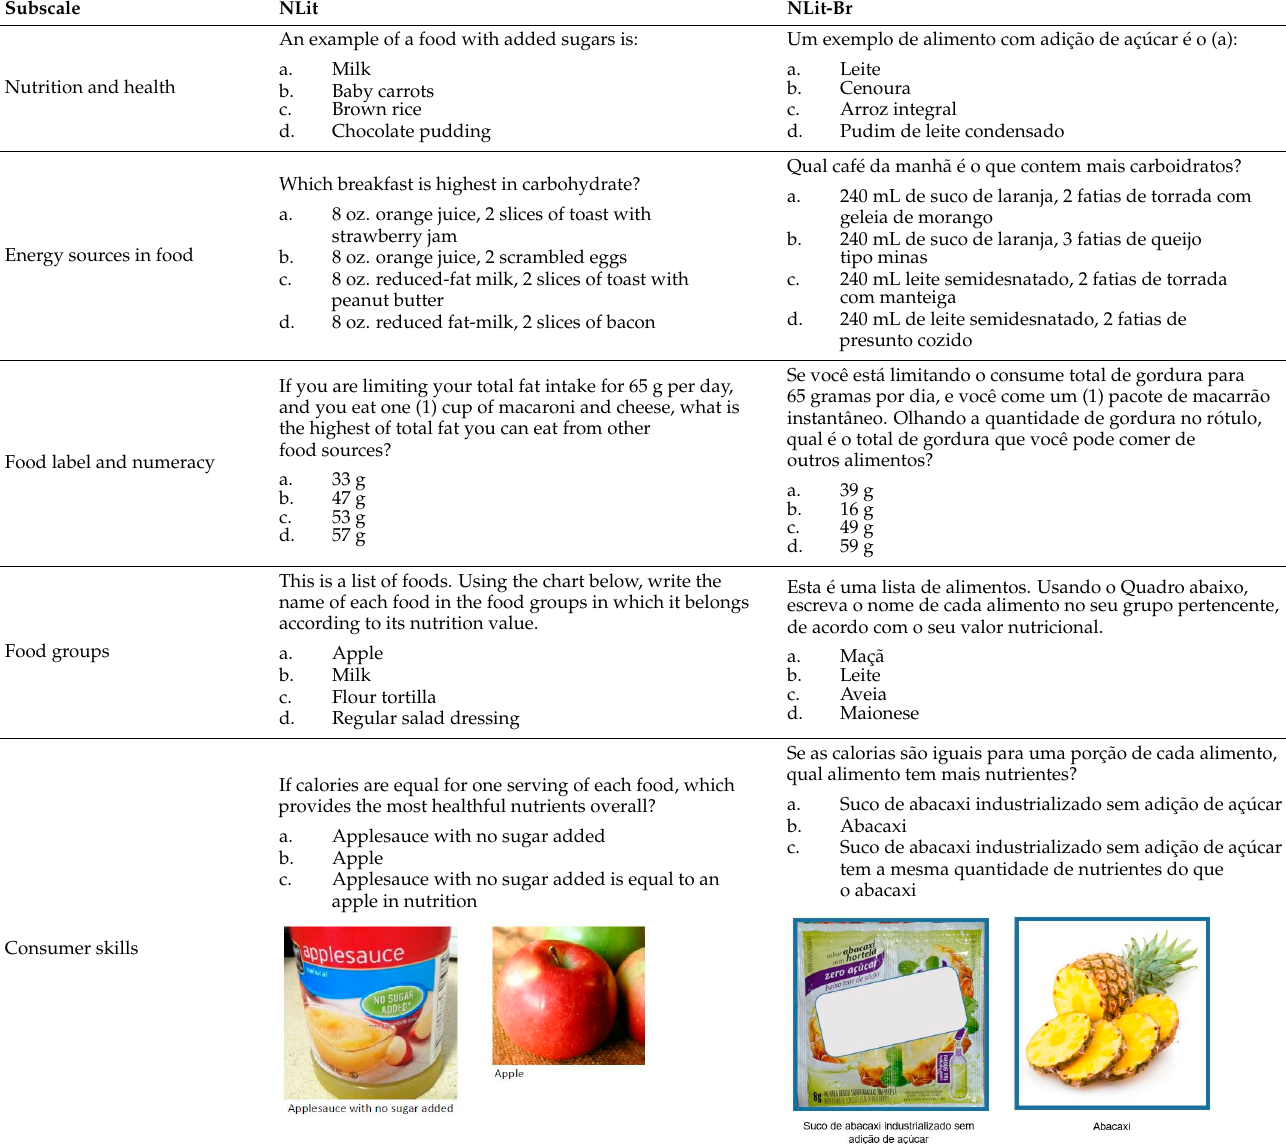
Table 2. Example of cultural adaptation and substitution of the original instrument items for Brazilian context.